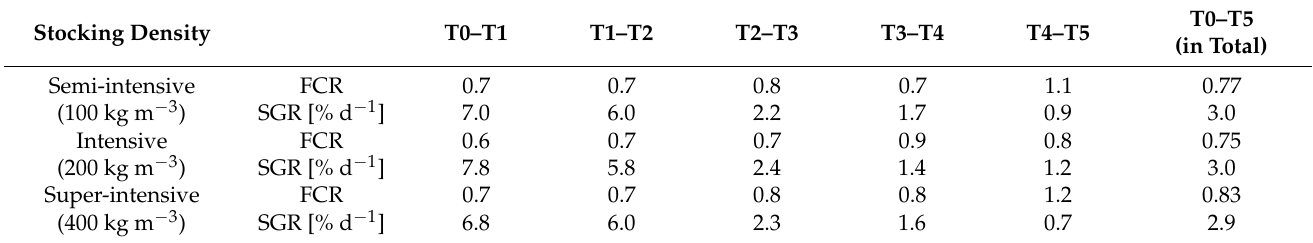
Table 3. The feed conversion ratio (FCR) and specific growth rate (SGR) of African catfish 1 week after stocking (T0–T1), after 6 weeks (T1–T2), after 12 weeks (T2–T3), after 18 weeks (T3–T4), and after 23 weeks, at the final weighing of all fish (T4–T5). Calculations are based on sub-samplings ( n = 18 per group), except totals (right column).